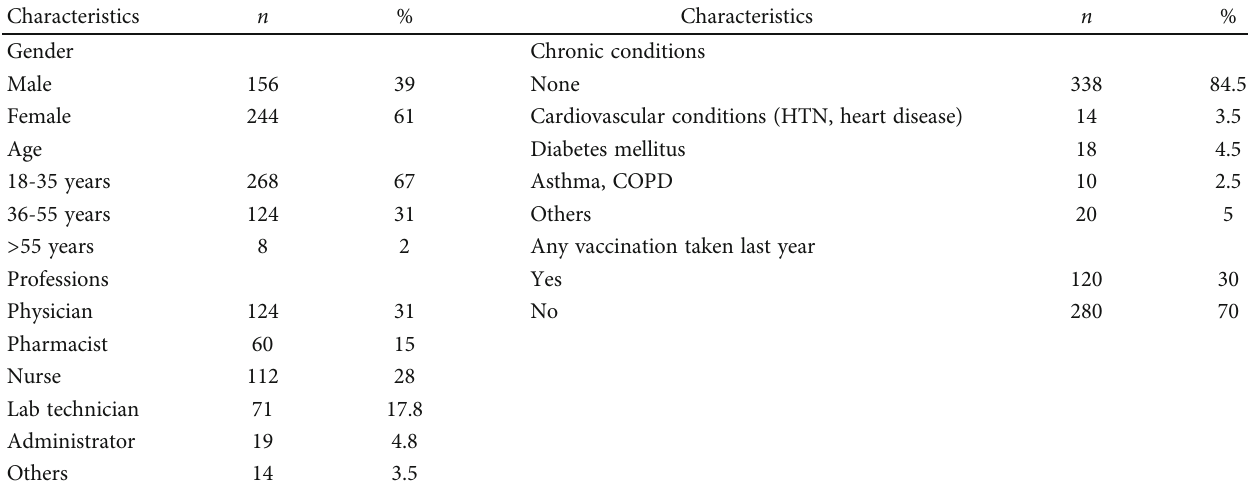
Table 1: Characteristics of the study participants ( n = 400 ).